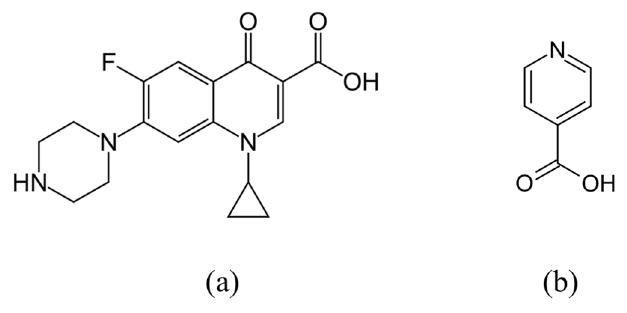
Figure 1. Molecular structure of ( a ) CIP, ( b ) INCA.